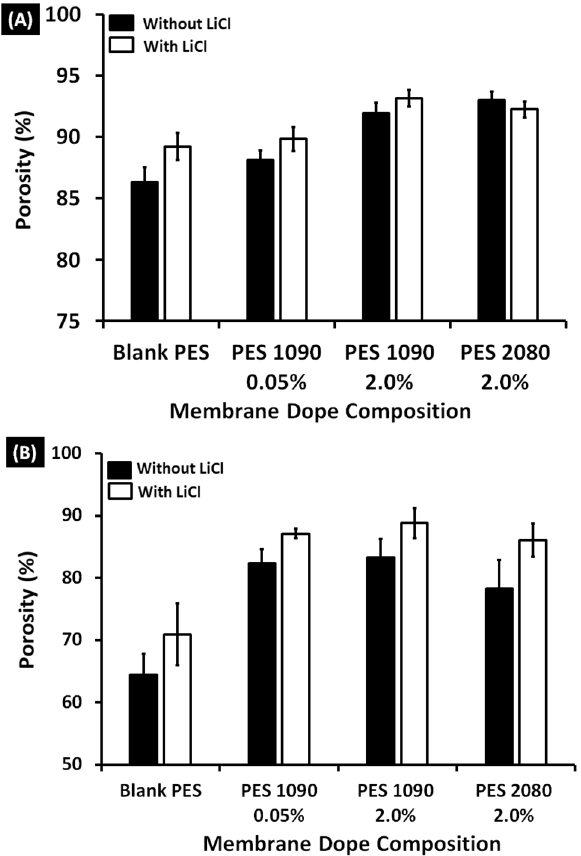
Figure 9. Porosity (%) of the blank PES and the magnetic mixed matrix PES membranes in absence (black bars) and precence (white bars) of 0.1 wt% of Lithium chloride in the membrane dope using absolute ethanol ( A ) and distilled water ( B